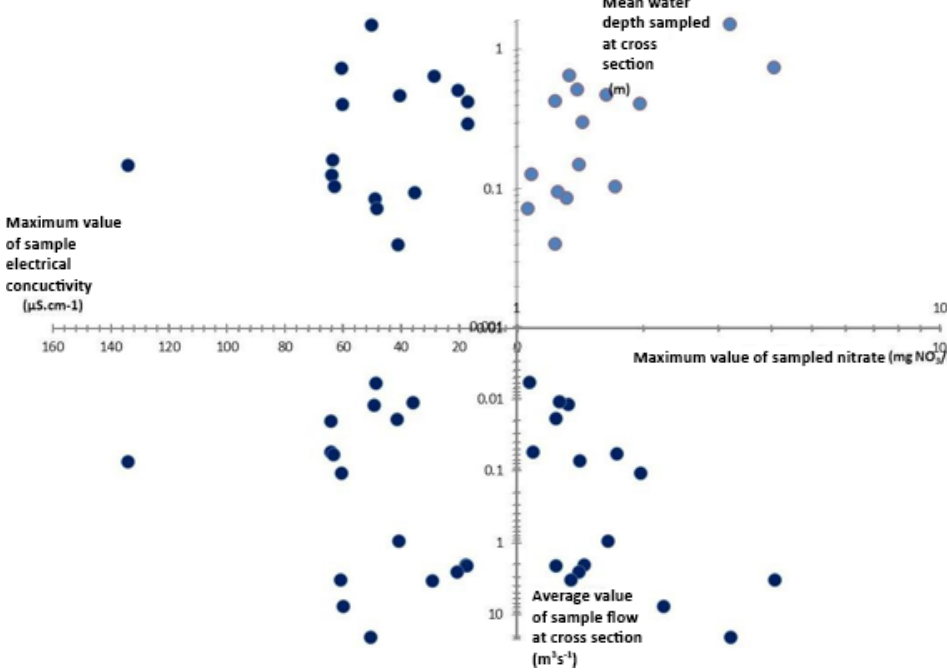
Figure 7. Multidimensional chart of hydraulic and water quality variables sampled in field campaigns in the headwaters of the Cantareira water supply system between October 2013 and May